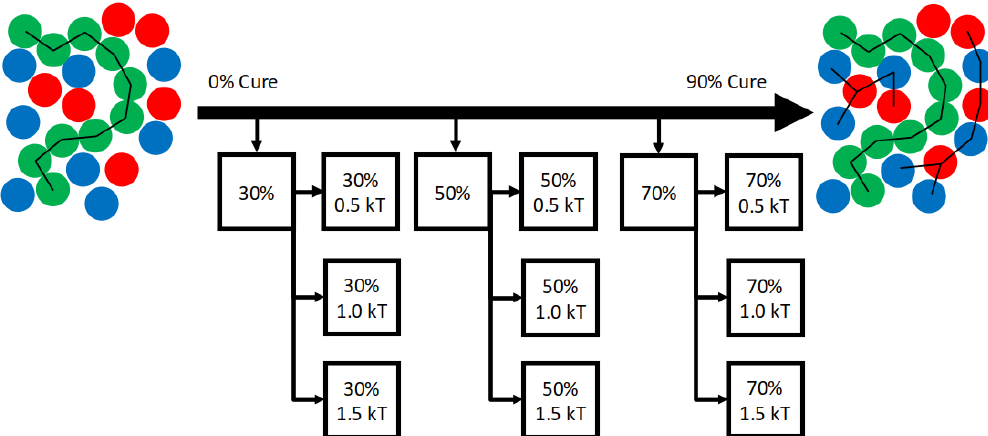
Figure 2. T g prediction workflow: Snapshots at specified α are copied from a curing simulation